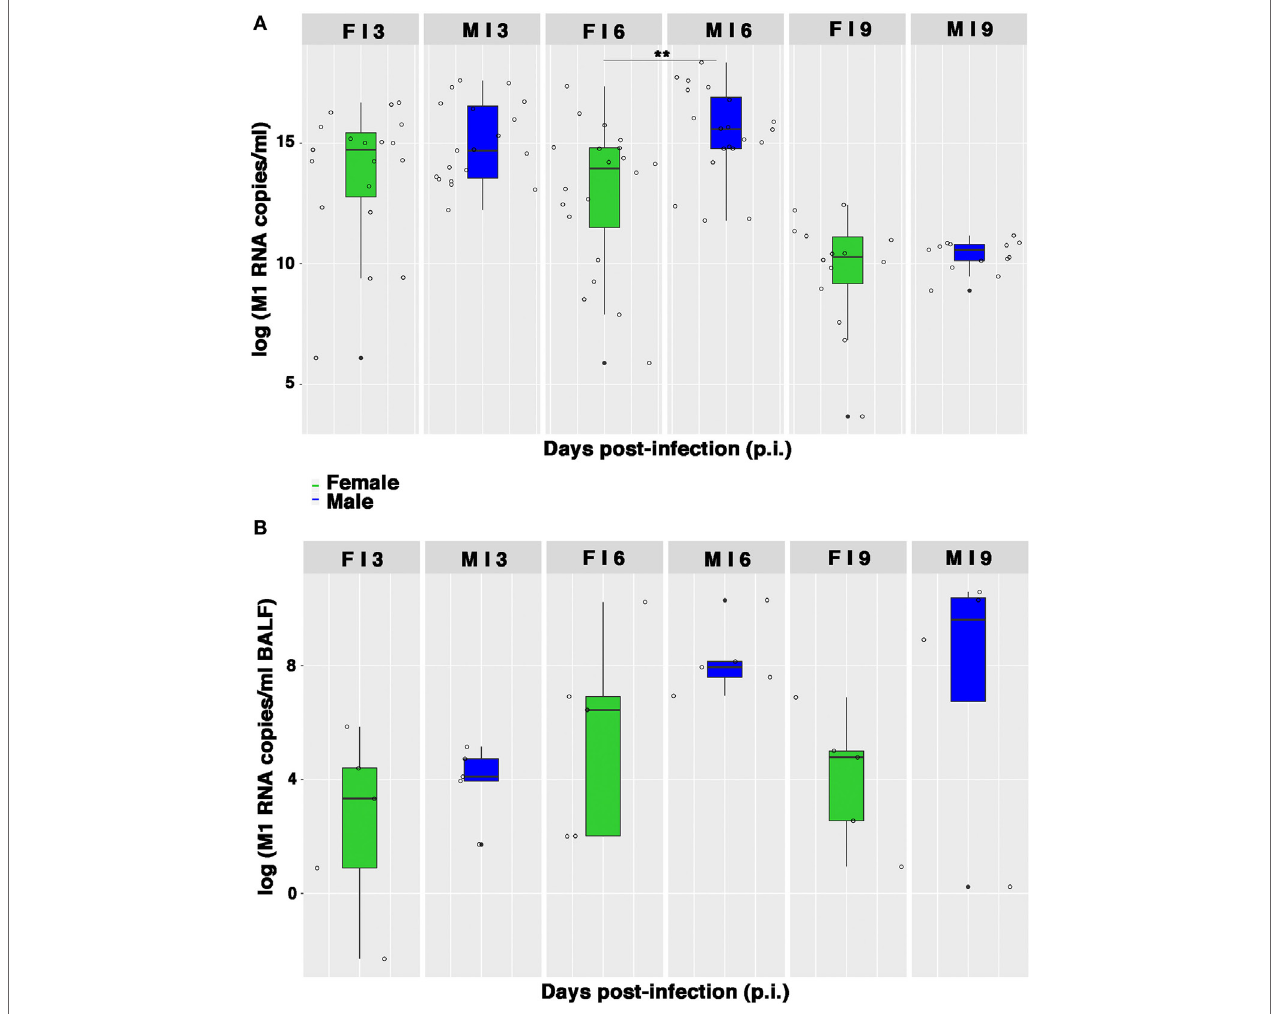
FigUre 5 | Viral M1 RNA copies are highly produced by infected males. (a) Box-plots of the viral M1 RNA copies measured by quantitative RT-PCR in homogenates of lungs collected on p.i. days 3, 6, and 9. Results represent data pooled from four independent experiments, each performed with five females and five males for each time-point ( n = 20/sex), ** p -value = 0.004. (B) Box-plots of the viral M1 RNA copies in BALF measured by RT-PCR on p.i. days 3, 6, and 9. Data shown are from one of the three experiments performed (each with five male and five female